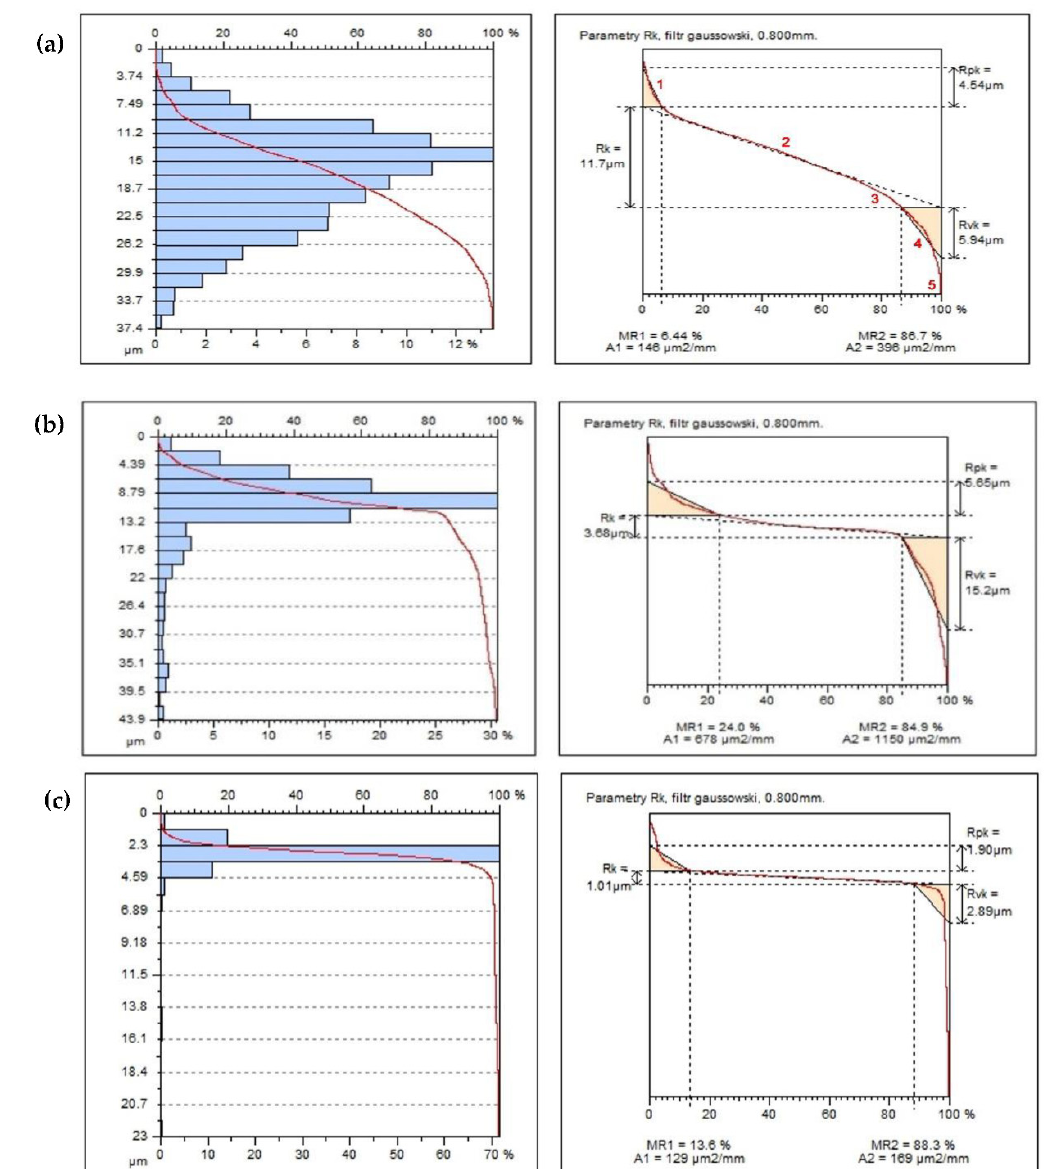
Figure 13. Material ratio in function of the profile height—( a ) 100% resin, ( b ) 5% resin and 95% brass, ( c ) 5% resin and 95% aluminum